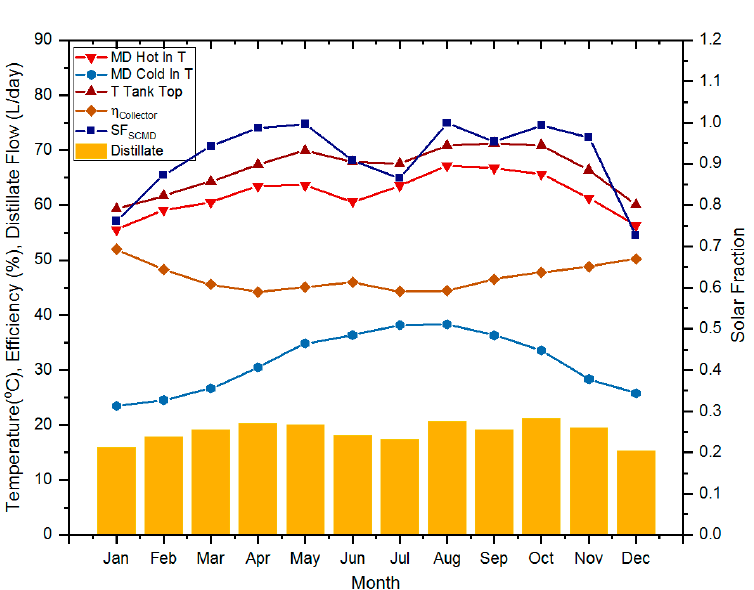
Figure 22. Annual simulation of SCMD system for co-production.